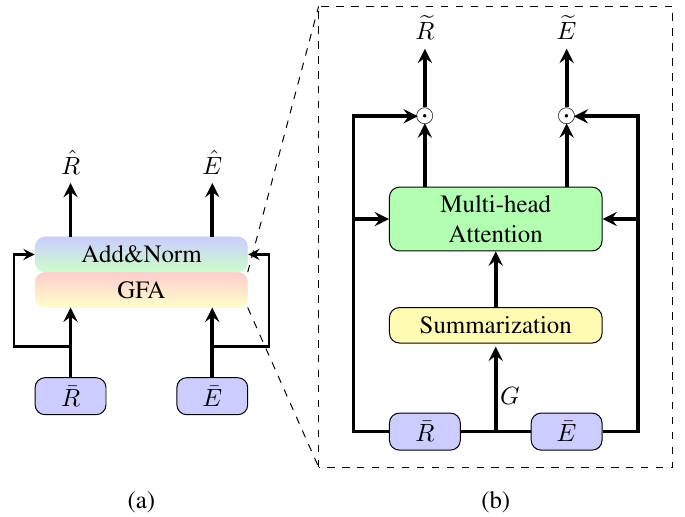
Figure 2. ( a ) Illustration of the global fusion attention (GFA) layer. ( b )Illustration of the GFA block. See the details in Section